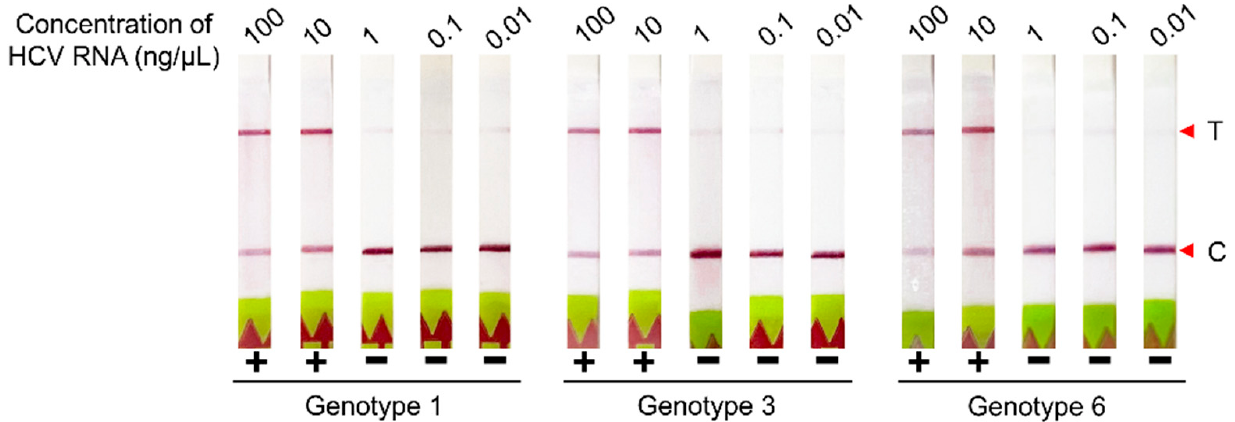
Figure 5. Determination of LoD of the RT-LAMP-coupled CRISPR–Cas12 assay. LoD was performed with HCV genotype 1, 3, and 6 at various input concentrations of HCV RNA: 100, 10, 1, 0.1, and 0.01 ng/µL. T, Test line; C, Control line.